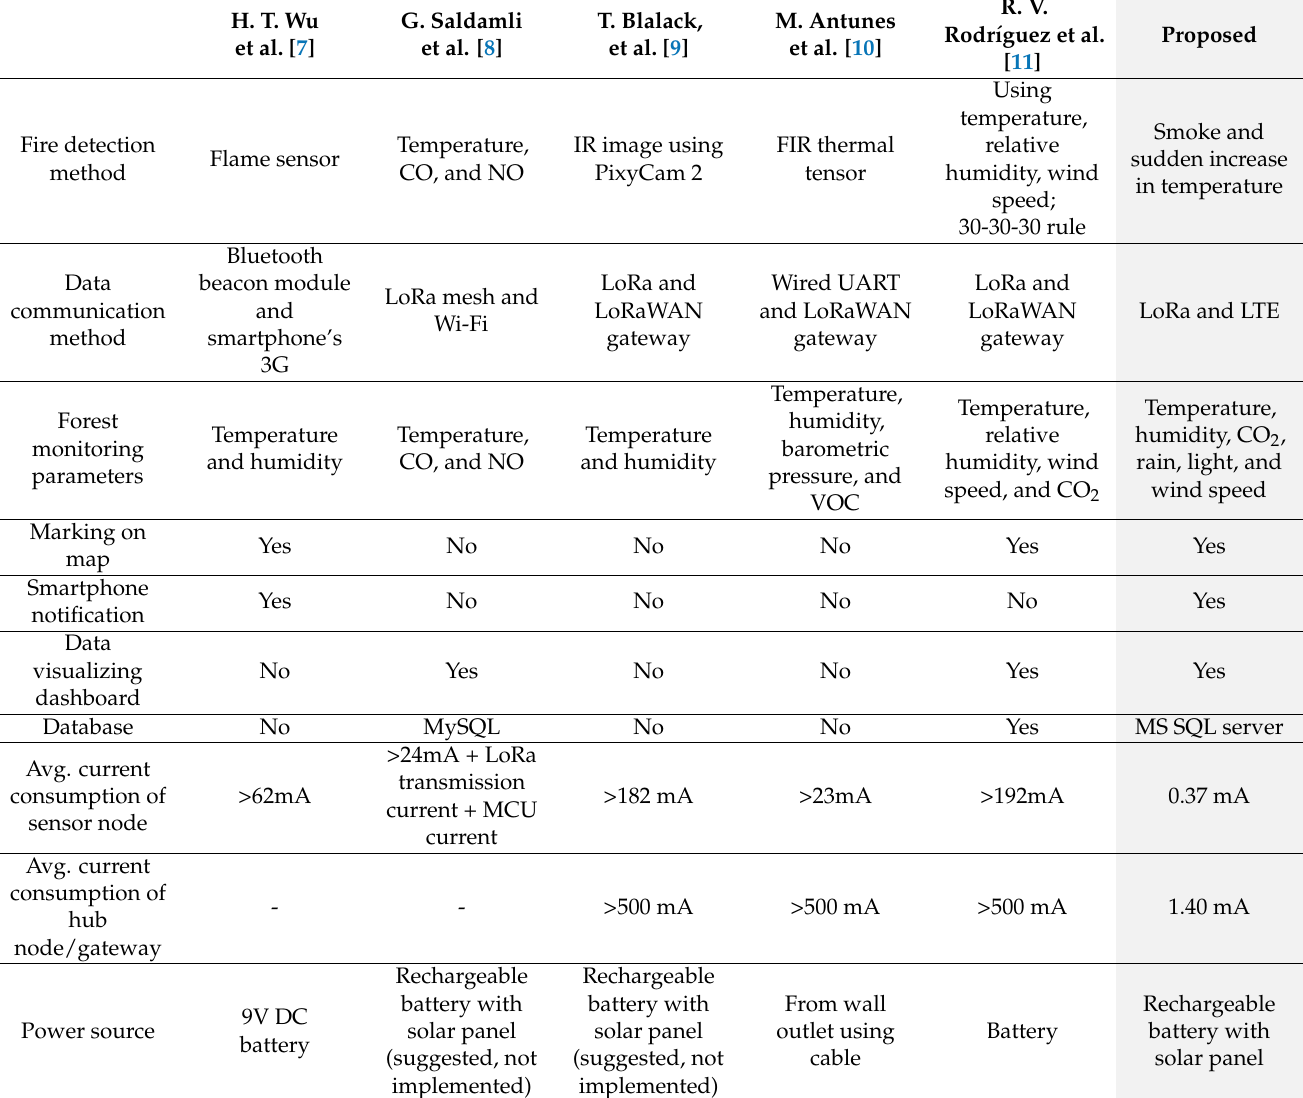
Table 1. Comparison with other